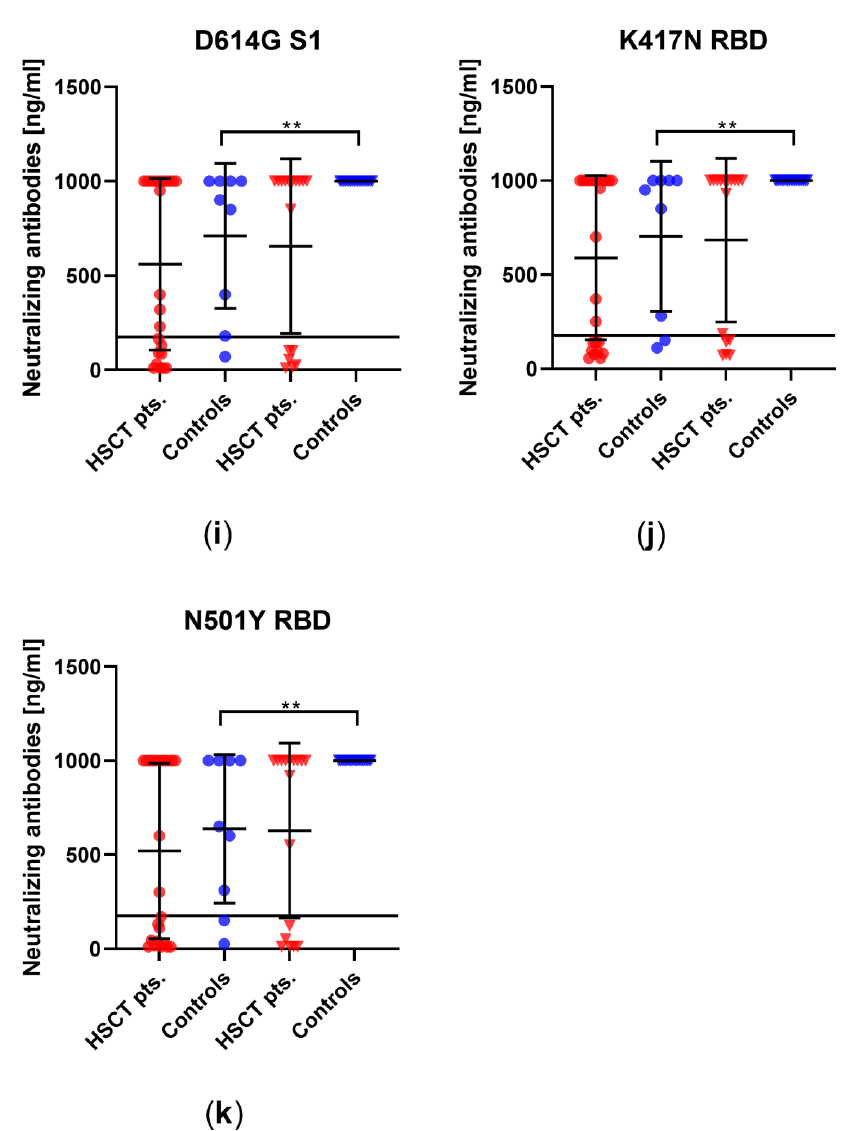
Figure 3. Concentration of neutralizing antibodies against different variants of the subunit 1 of spike protein (S1) or the receptor-binding domain (RBD) of SARS-CoV-2 in HSCT patients and healthy controls before and after third vaccination. Humoral responses before and after third vaccination against ( a ) wildtype S1, ( b ) wildtype RBD, ( c ) alpha, ( d ) beta, ( e ) gamma, ( f ) E484K, ( g ) epsilon, ( h ) kappa, ( i ) D614G, ( j ) K417N, and ( k ) N501Y. D614G is a mutation found in delta and omicron variants, while K417N and N501Y are mutations in the omicron variant. Circles indicate data before the third vaccination (red—HSCT, blue—healthy controls), while triangles indicate data after the third vaccination. Responses were compared by two-tailed Mann–Whitney test (** p < 0.01, *** p < 0.001, **** p <0.0001). Horizontal lines indicate mean values, while error bars indicate the standard